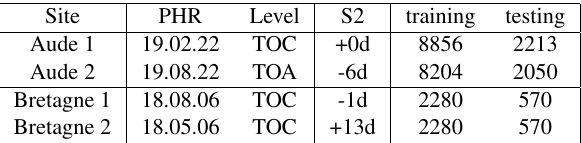
Table 1. Characteristics of the datasets used for the experiments. Data downloaded from Dinamis portal (PHR, Aude), Kalideos portal (PHR, Bretagne) and Theia portal (Sentinel-2, all sites). All Pleiades images displayed in this paper are ©CNES (2018,